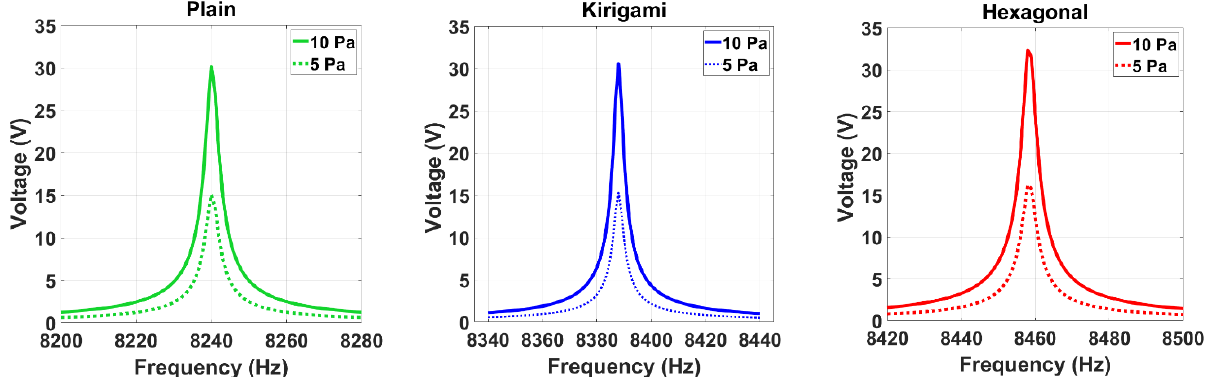
Figure 11. Simulated voltage output against frequency. All points use the same excitation of 5 Pa and 10 Pa.